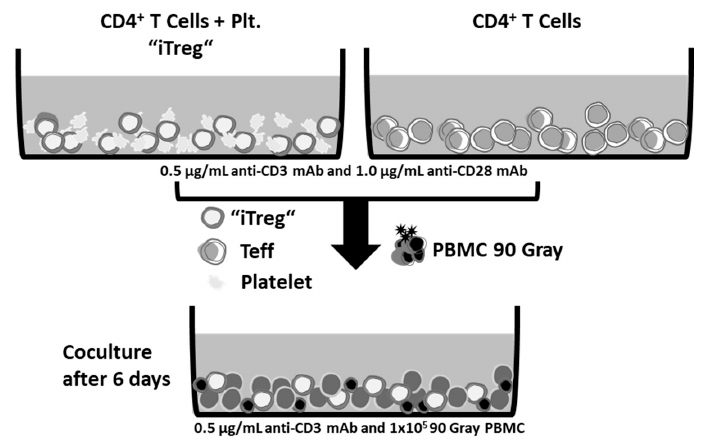
Figure A3. Experimental setup of a platelet-conditioned T cell suppression assay. 1 × 10 6 CD4 + CD25 − T cells were stimulated with 0.5 µg/mL anti-CD3 mAb and 1.0 µg/mL anti-CD28 mAb with or without 50 × 10 6 platelets for 6 days. T cells cocultured with platelets developed an iTreg-like phenotype, whereas T cells cultured without platelets displayed a Teff phenotype. Next, iTreg and Teff were cultured at different ratios (iTreg/Teff: 1:1, 1:2, 1:4, and the corresponding controls) and restimulated with 0.5 µg/mL anti-CD3 mAb and 90Gy irradiated PBMC. Proliferation (Ki-67) was measured via flow cytometry 3 days after restimulation.